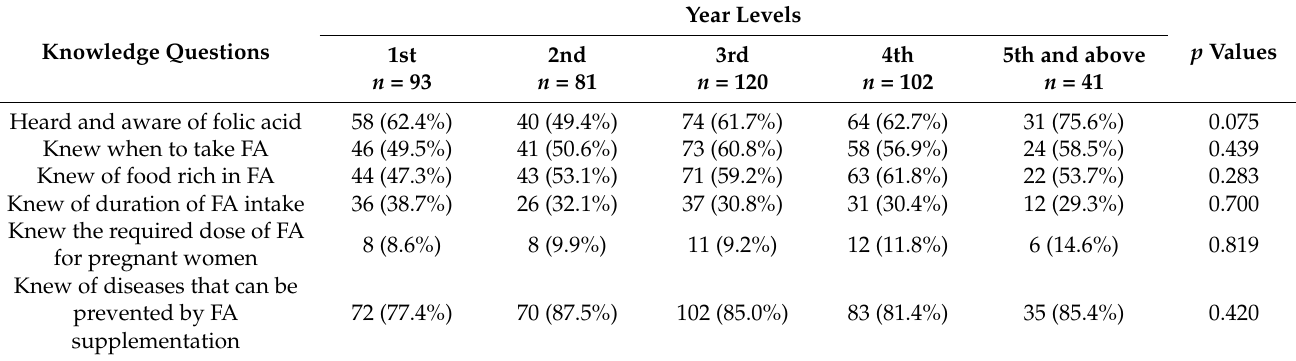
Table 3. Responses to knowledge and awareness according to year